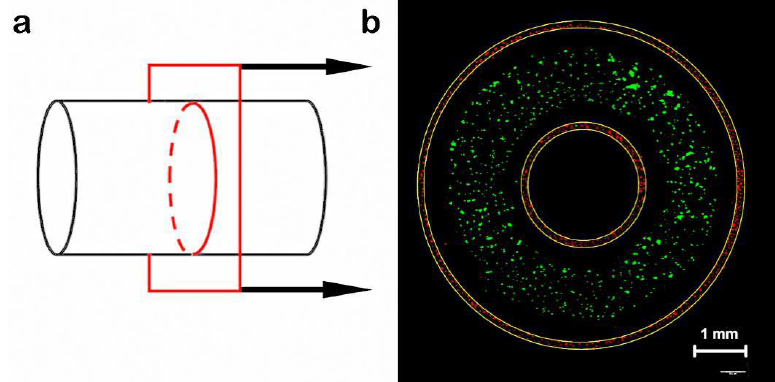
Figure 12. ( a ) Schematic views of cross section. ( b ) An arteriovenous structure with three layers, in which the outer red, green and inner red parts correspond to the HDF-n-laden adventitia, HA-VSMC-laden media, and HUVEC-laden intima, respectively. Actual pictures of the 3D arteriovenous construct were acquired using three fluorescent labels (Scale bar: 1 mm).